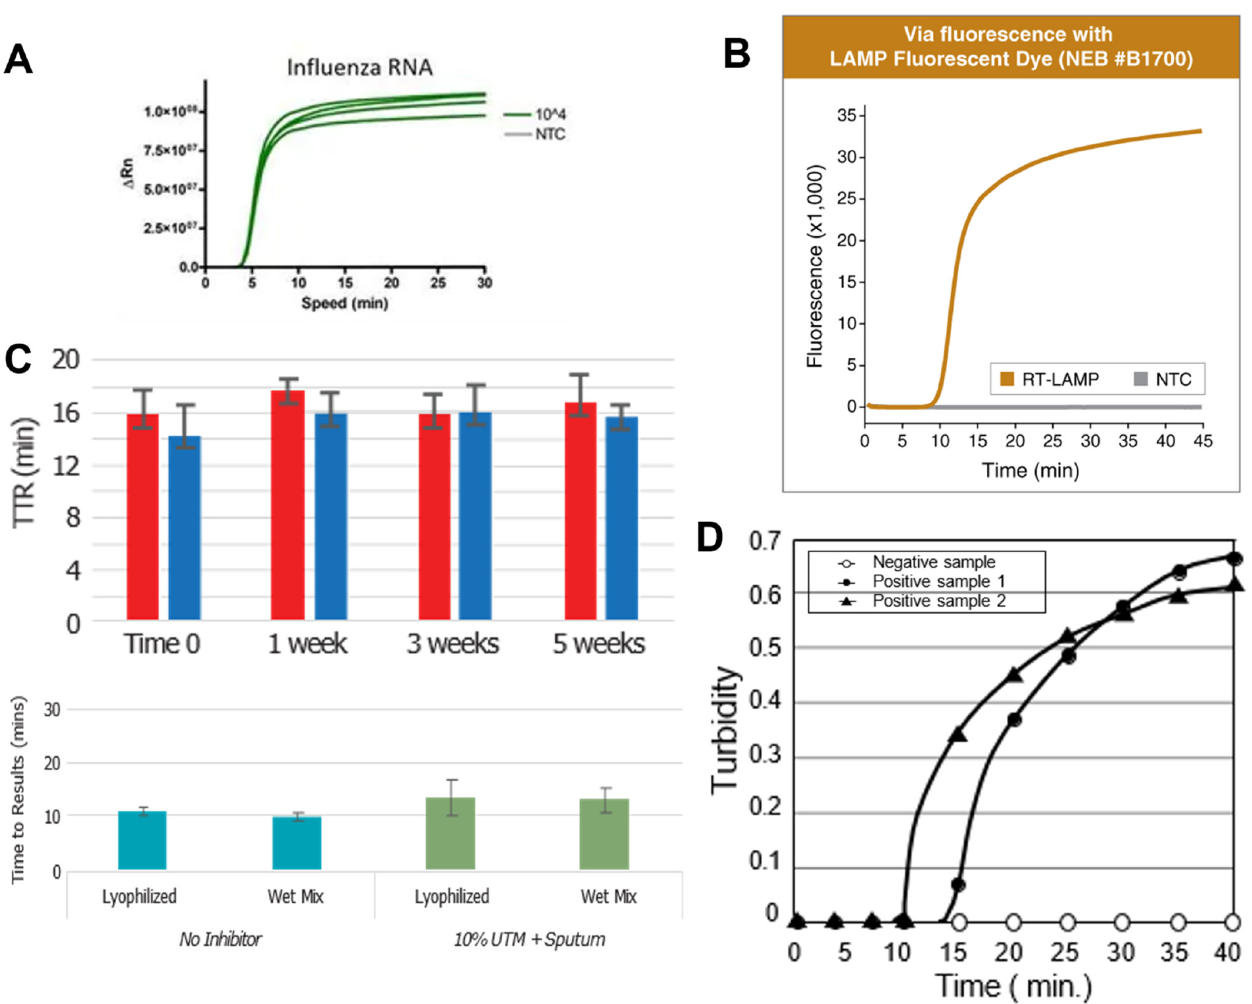
Figure 3. Leading LAMP reagents’ performance. ( A ) The reaction time of Thermo Fisher SuperScript™ IV RT-LAMP Master Mix for multiple pathogens. Reprinted with permission from [77]. Copyright 2022, Thermo Fisher. ( B ) Real-time NEB WarmStart ® LAMP kit (DNA & RNA) real-time and end-point detection and fluorescence & turbidity detection. Reprinted with permission from